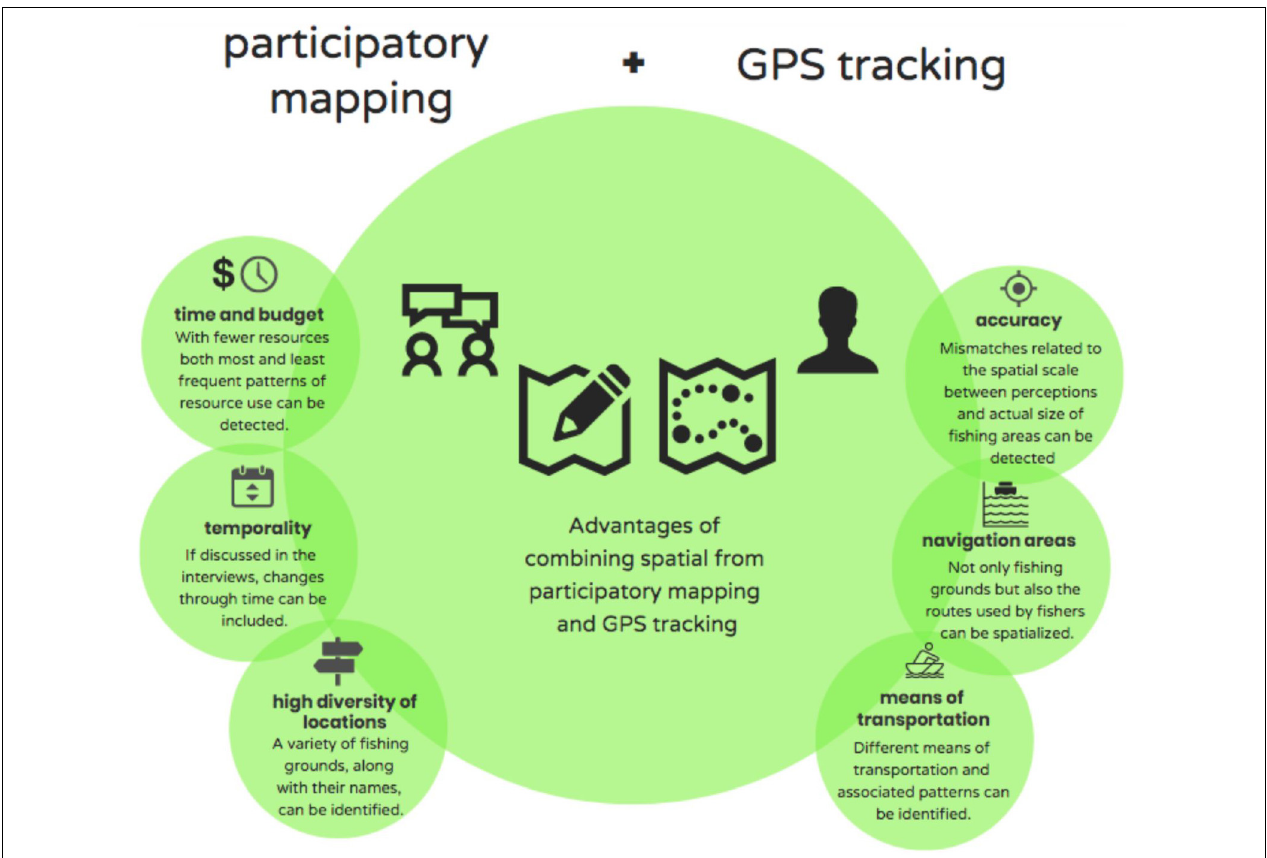
FIGURE 3 | The benefits of combining participatory mapping and GPS